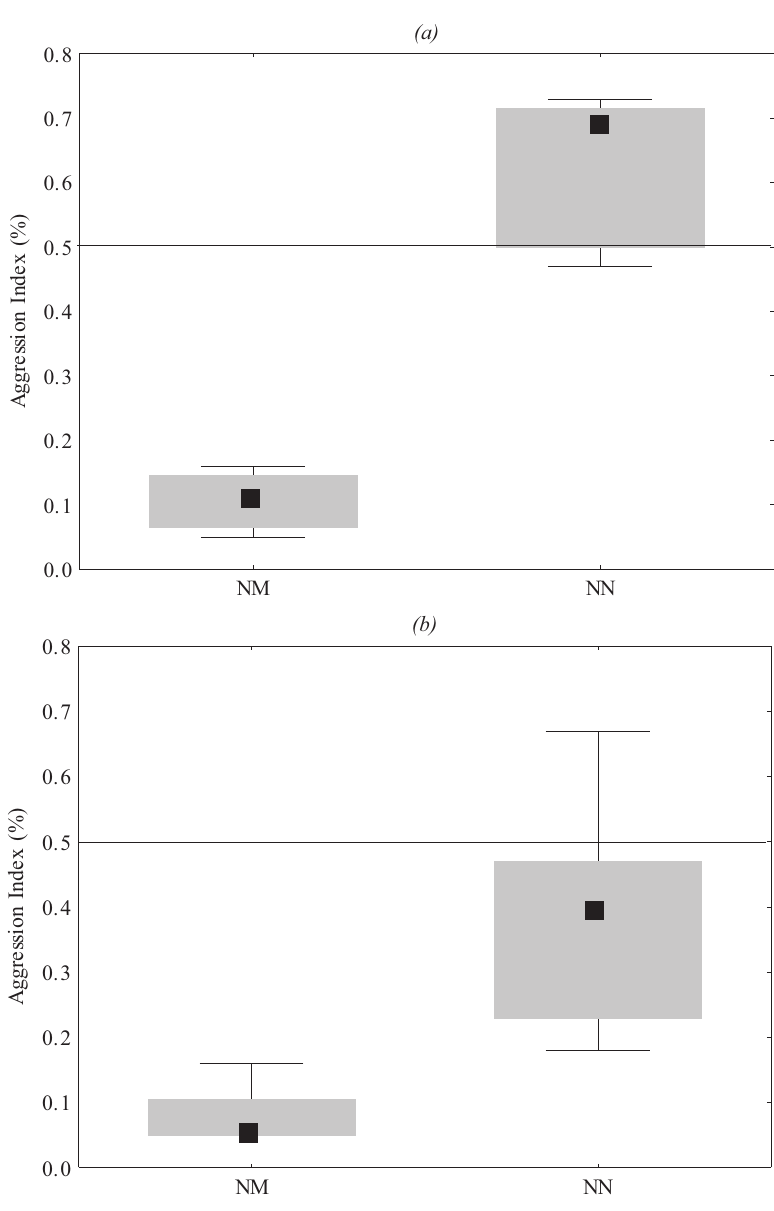
Figure 2. Frequency of aggression indexes between colonies from group-A vs. group-B at ( a ) Phase I and ( b ) Phase II. NM = nestmates; NN = non-nestmates. Black dots = mean; gray boxes = standard error; whiskers = standard